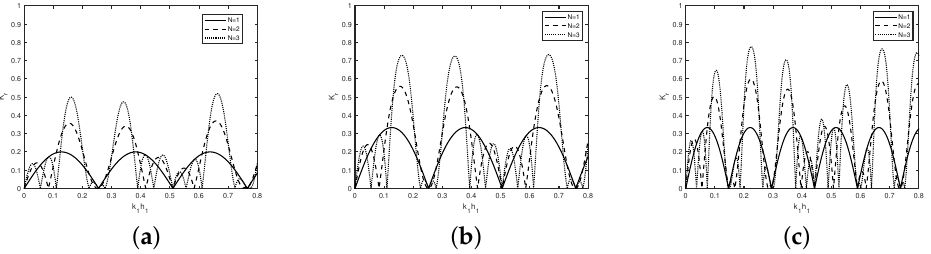
Figure 8. Reflection coefficient K r versus wave number k 1 h 1 for different number N of rectangular trenches with ( a ) width w / L 1 = 0.6, gap d / L 1 = 0.86, and breakwaters with ( b ) width w / L 1 = 0.35, gap d / L 1 = 0.60 and ( c ) width w / L 1 = 0.6, gap d / L 1 = 0.86 in the absence of the semi-infinite plate.